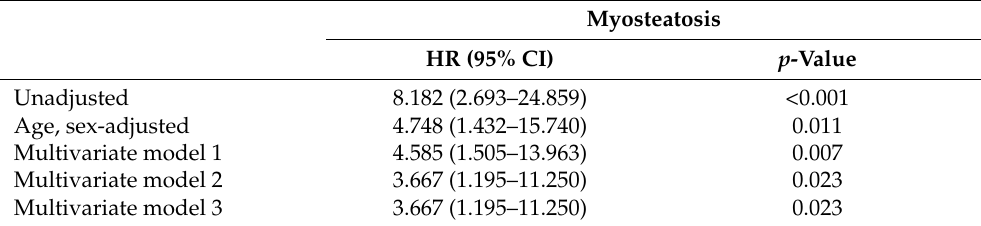
Table 4. An adjusted hazard ratio of myosteatosis for predicting mortality in patients with COVID-19. Myosteatosis HR (95% CI) p -Value Unadjusted 8.182 (2.693–24.859) <0.001 Age, sex-adjusted 4.748 (1.432–15.740) 0.011 Multivariate model 1 4.585 (1.505–13.963) Multivariate model 2 3.667 (1.195–11.250) Multivariate model 3 3.667